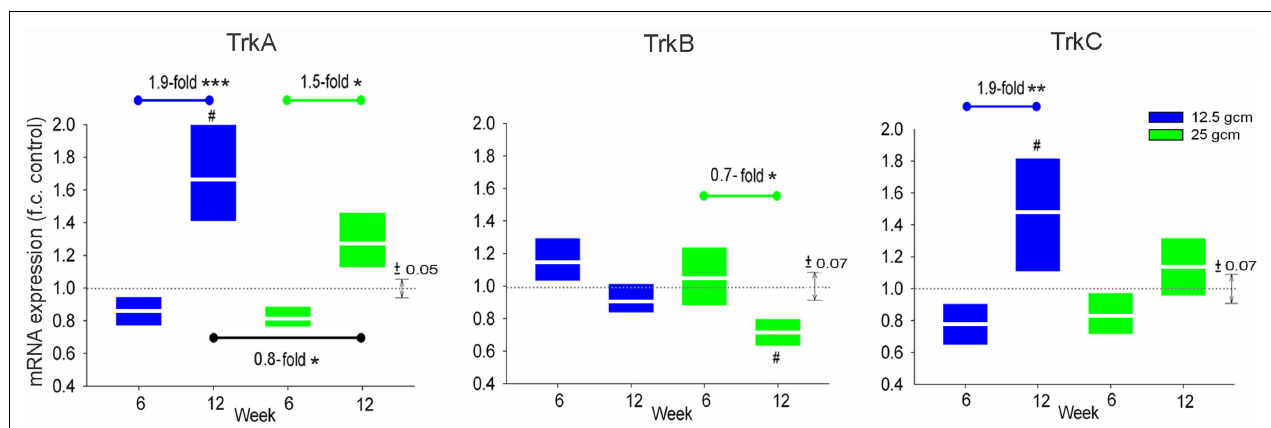
FIGURE 2 | mRNA expression ofTrk receptors is altered in L4/5 DRG at 6 and 12weeks after receiving either 12.5gcm (blue) or 25gcm (green) NYU contusion injury to spinal cord at vertebral levelT9. Fold-change (FC) is reported as change of 12week relative to 6week time points in all figures. Black bar onTrkA reports fold-change (fc) of 25gcm at 12weeks relative to